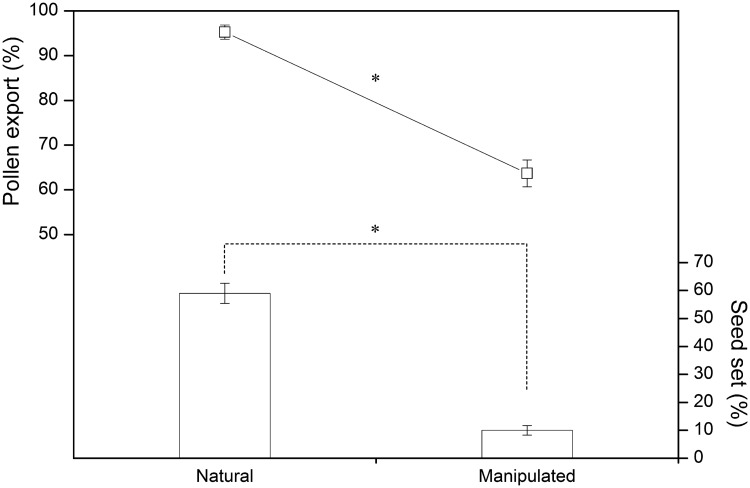
The effect of herkogamy treatments on pollen export and seed set. (‘*’ P < 0.01, Student’s t-test, Nnatu = Nmani = 20).